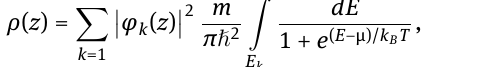
are the vector and scalar potentials associated with the applied   V r is the potential determined by the quantum